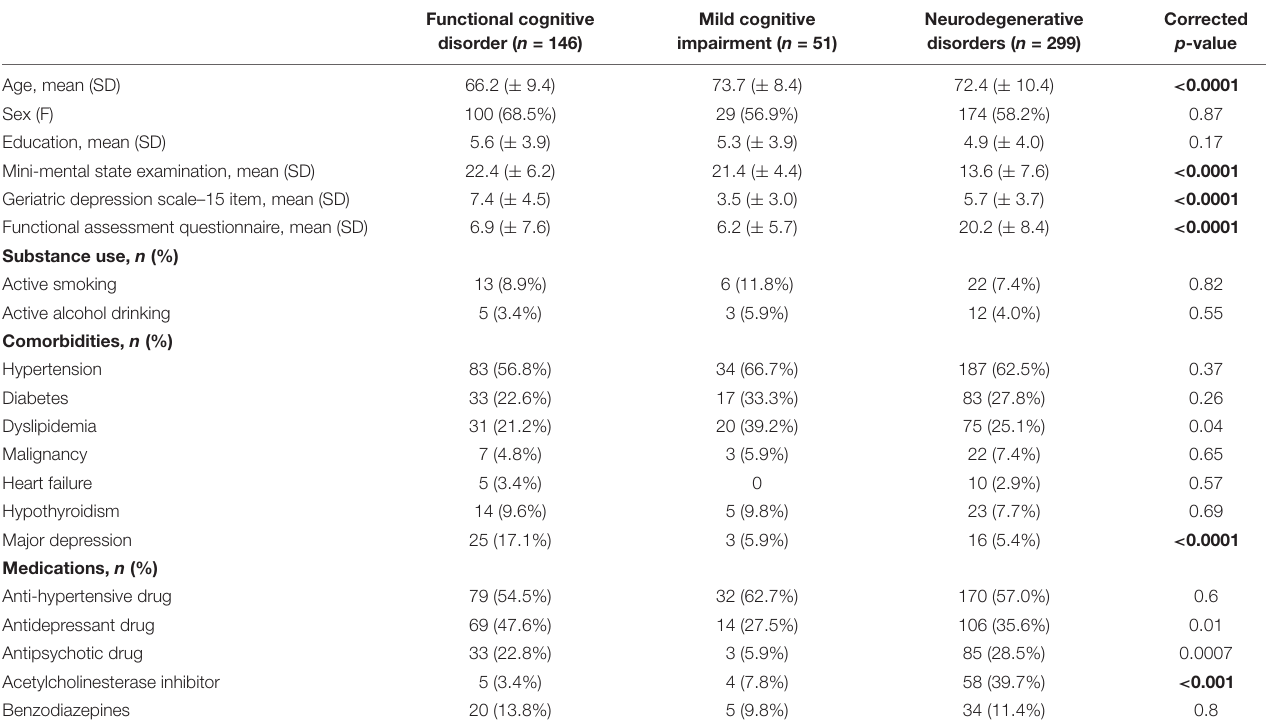
TABLE 1 | Demographic and clinical characteristics of patients that attended the memory clinic within the period of 2014–2021.